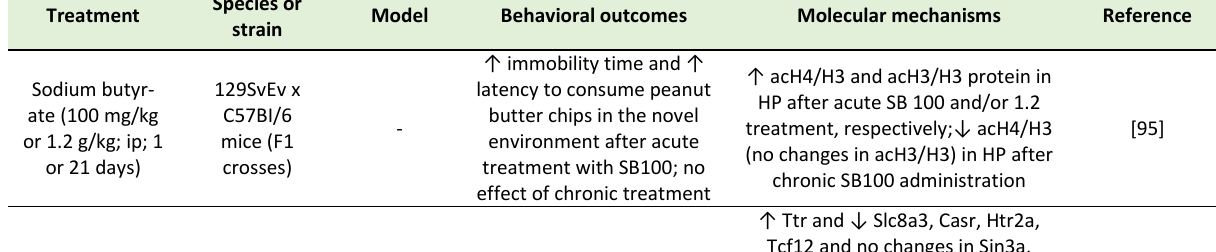
TABLE 3. Studies investigating the effects of SCFAs on depressive-like behavior. Species or Treatment Model Behavioral outcomes Molecular strain